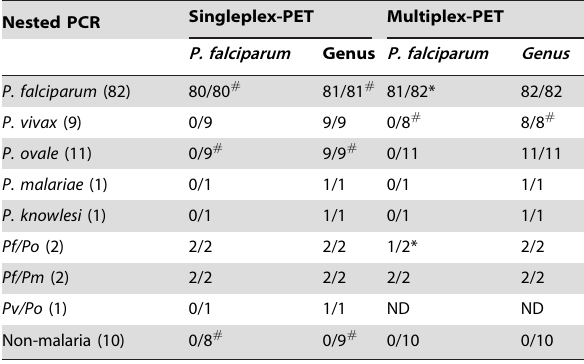
Table 4. Comparison of PET–PCR to nested PCR using clinical